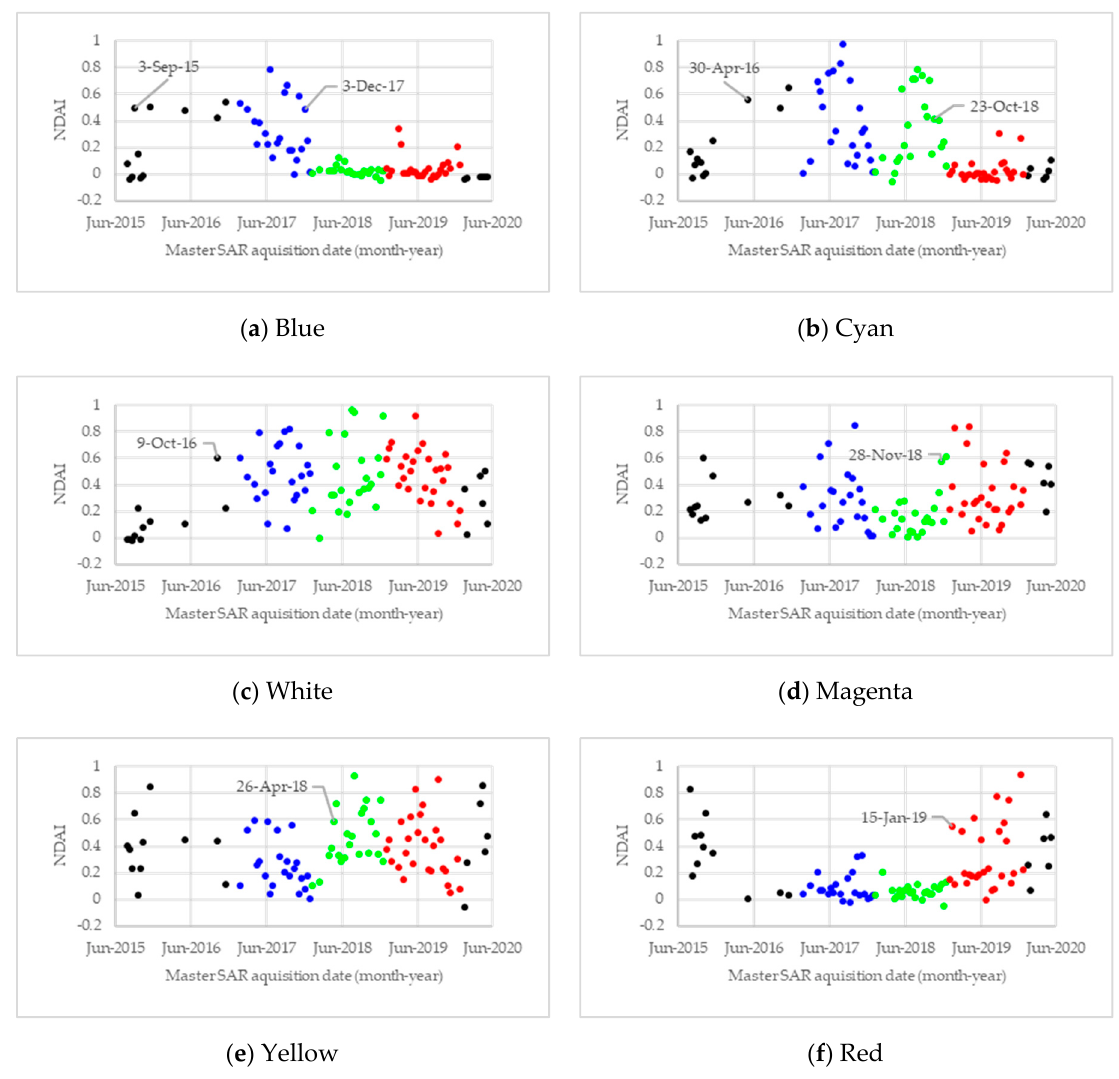
Figure 20. The 12-day NDAI time-series graphs of ED1 showing the detailed activation or deactivation date in ( a ) blue (B), ( b ) cyan (C), ( c ) white (W), ( d ) magenta (M), ( e ) yellow (Y), and ( f ) red (R) points in Figure 19c. The red, green, and blue dots in the graphs indicate the data used for generating the RGB composite of the annually averaged NDAI images, while black dots were not.